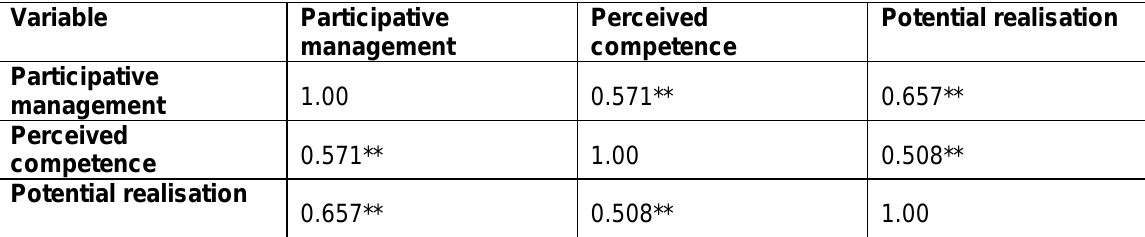
Potential realisation